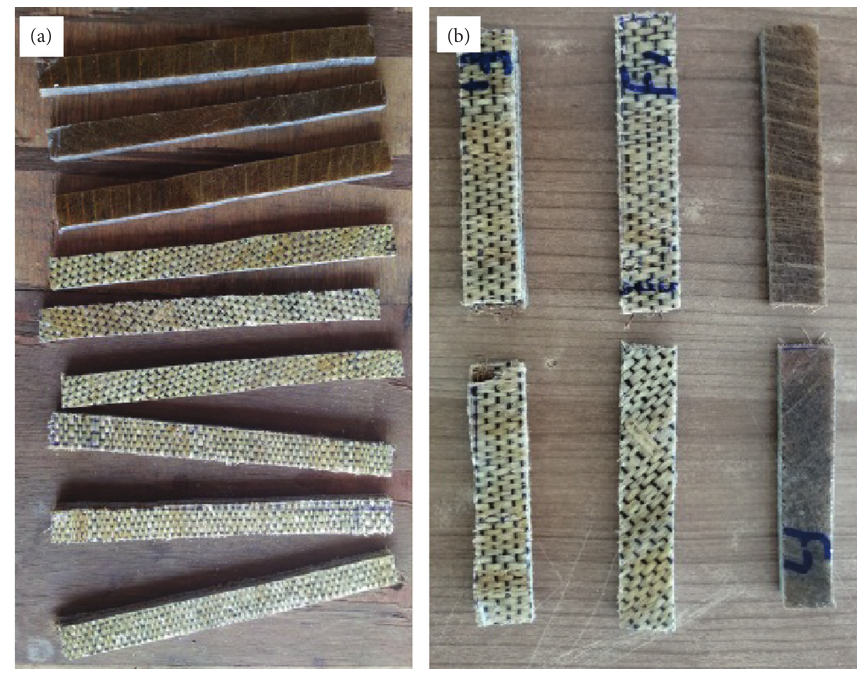
Figure 2: Flexural test specimens (a) before and (b) after the test.